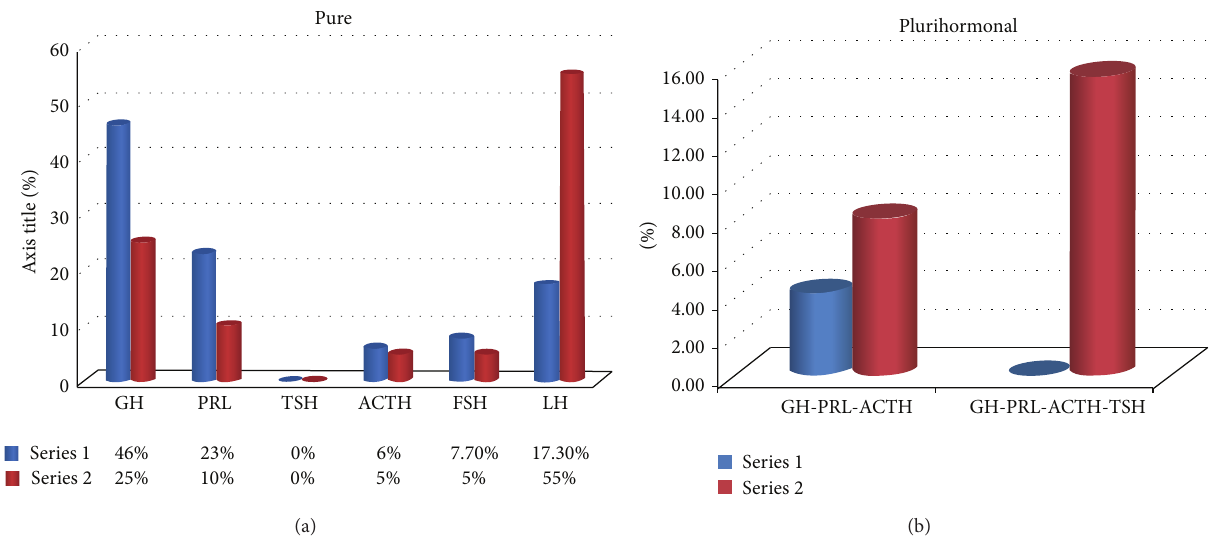
Figure 3: Graphic distribution of pure pituitary adenomas (a) and plurihormonal adenomas (b) between the two groups. The particular high number of GH- and LH-secreting pure adenomas (a) and plurihormonal adenomas with triple and quadruple hormone (b) associations was specific for group 2 (pituitary adenomas from Moldova), compared with group 1 (pituitary adenomas from